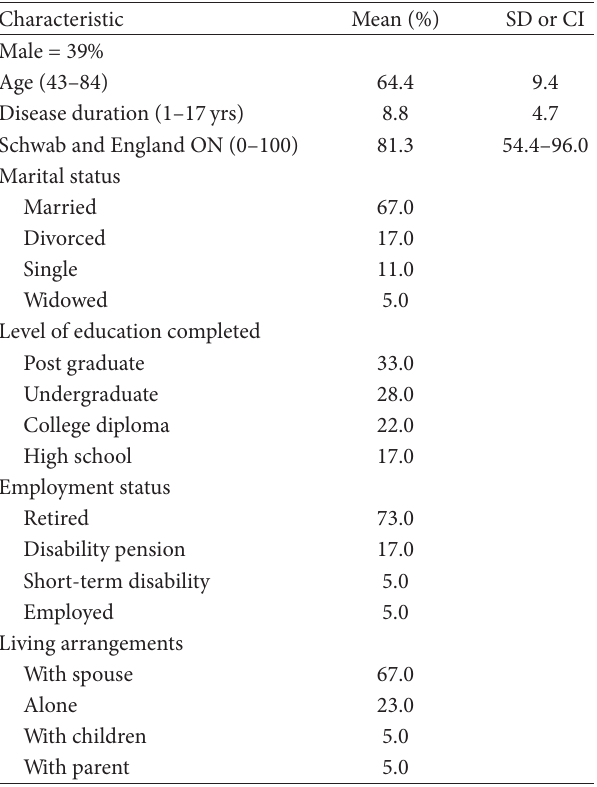
F 1: Summary scores for informational categories